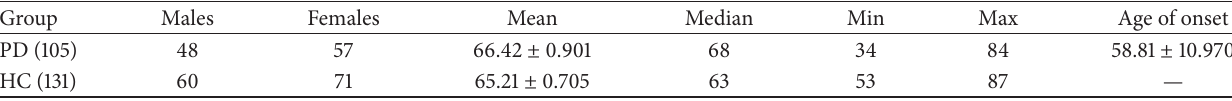
Table 1: Sociodemographic data of the PD patients and the